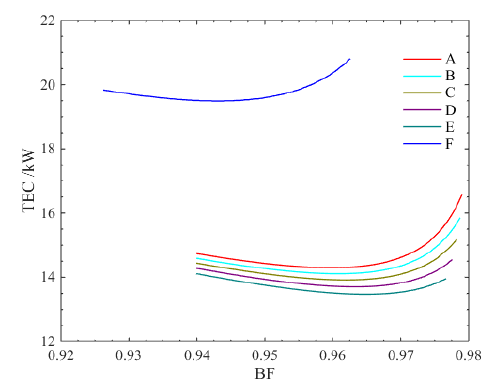
Figure 13. The effect of BF on total energy consumption (TEC). Figure 13. The e ff ect of BF on total energy consumption (TEC).